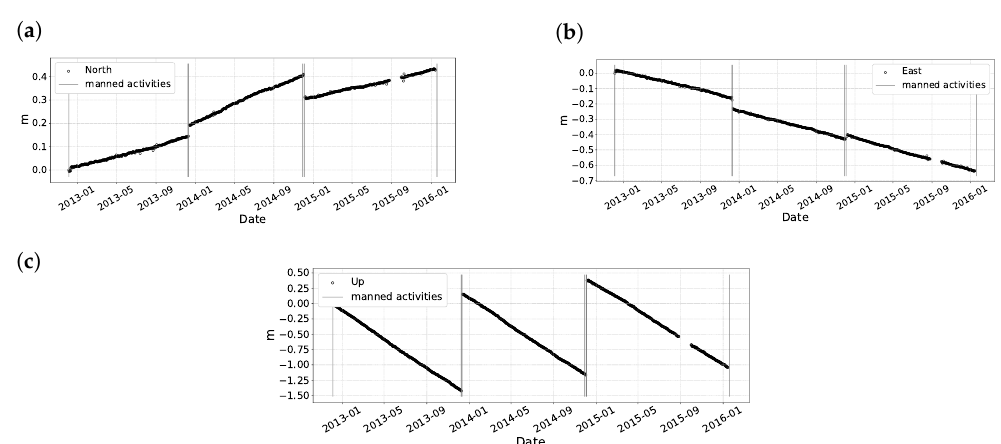
Figure 7. ROB1 antenna displacement in the north ( a ), east ( b ), and up ( c ) directions with respect to the first day position. Gray vertical solid lines indicate manned activity dates, where a mast of 1.6 m was added to prevent the antenna sinking in the snow.